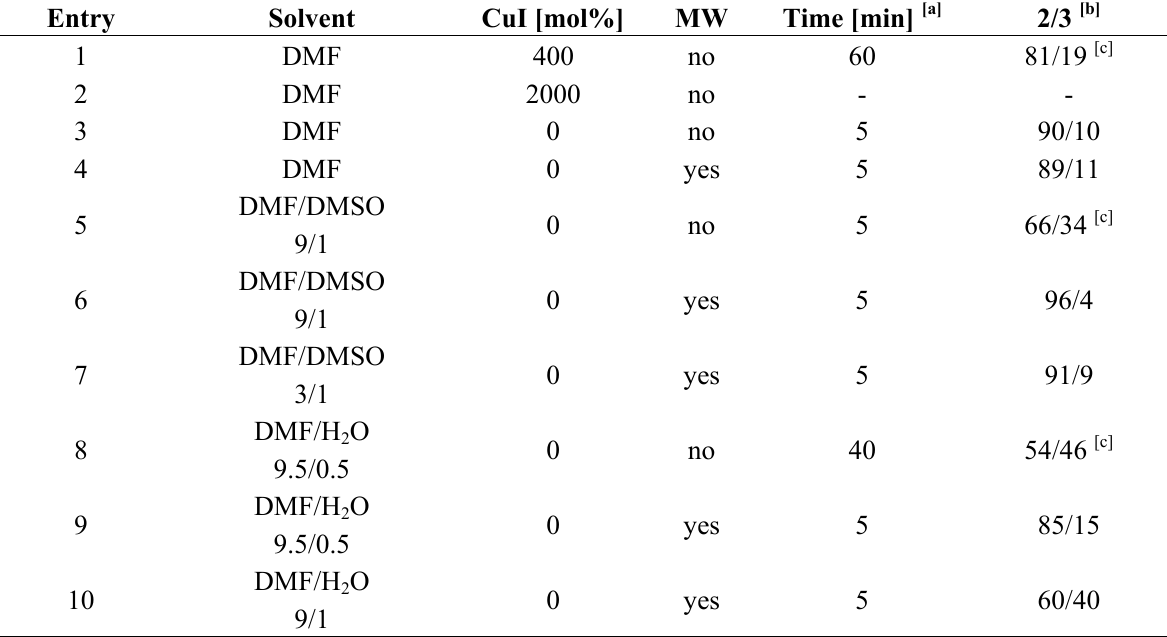
Table 2. Methyl transfer onto 1b under dilute conditions (5 × 10 − 3